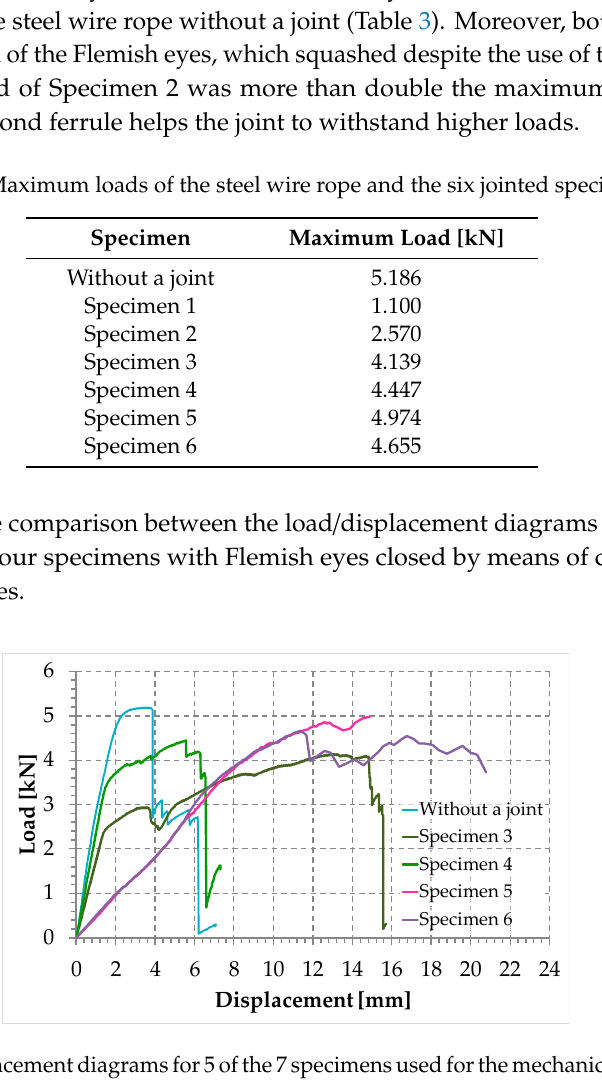
Table 3. Maximum loads of the steel wire rope and the six jointed specimens.